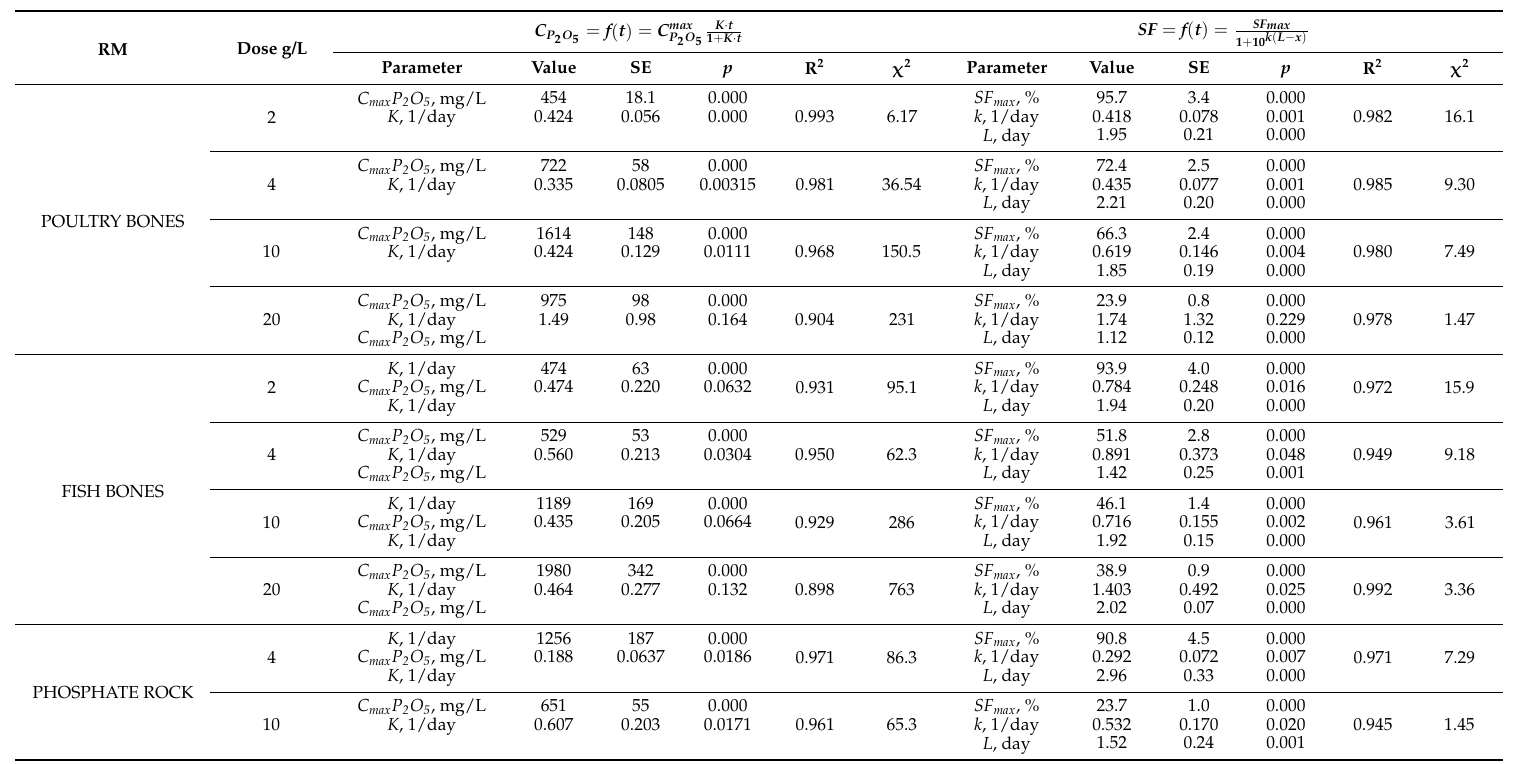
Table 2. Parameters of the model describing P 2 O 5 concentration changes during solubilization C P Solubilization Factor change during solubilization SF = f ( t )